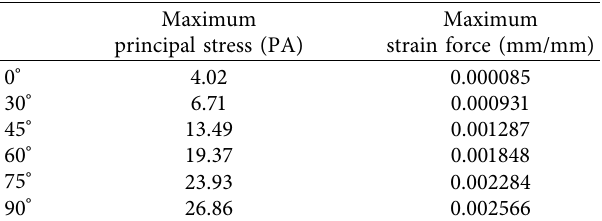
Table 2: Stress and strain distributions of nasal bone at diferent